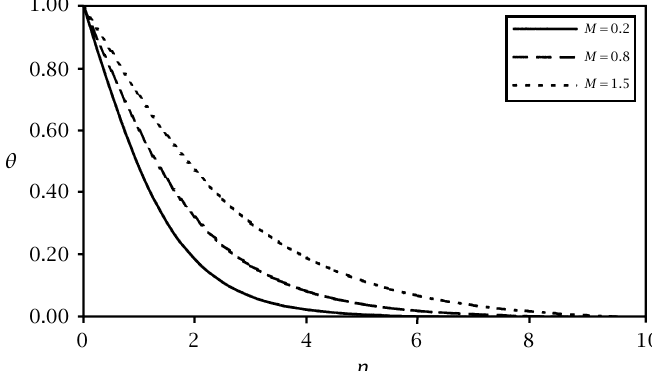
Figure 3.3 . The variation of θ against η for m = 0 . 1 and R = 1.